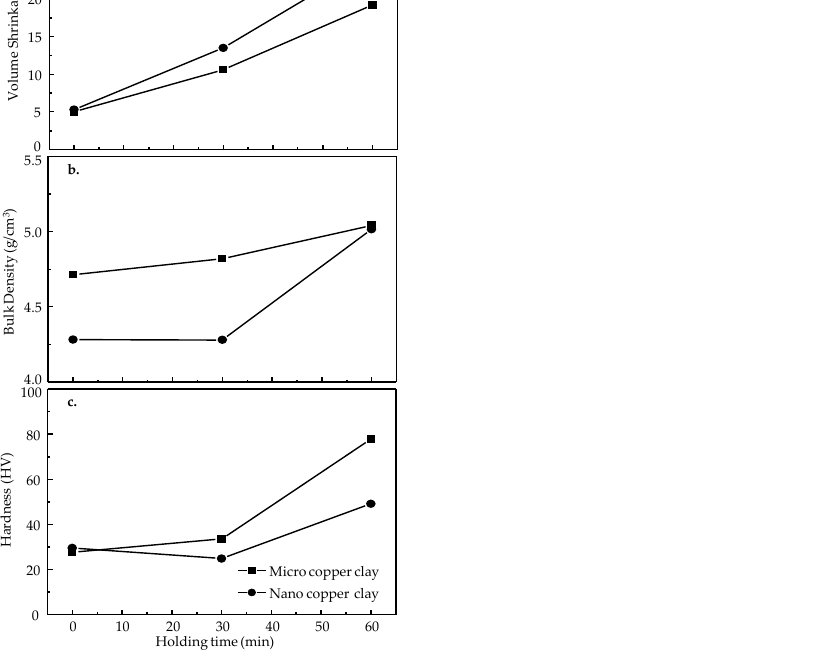
Figure 11. ( a ) Volume shrinkage, ( b ) bulk density, and ( c ) hardness of sintered nano- and micro copper clay with different holding times.